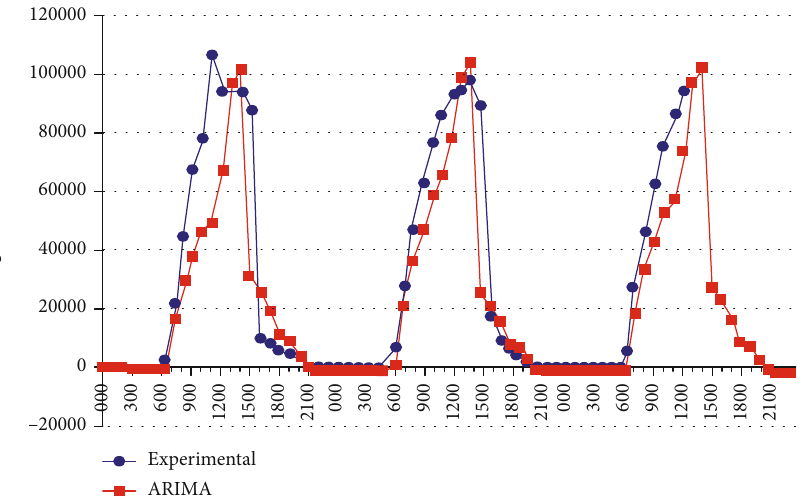
Figure 5: Adjusting the forecasted ARIMA data with the measured ones.